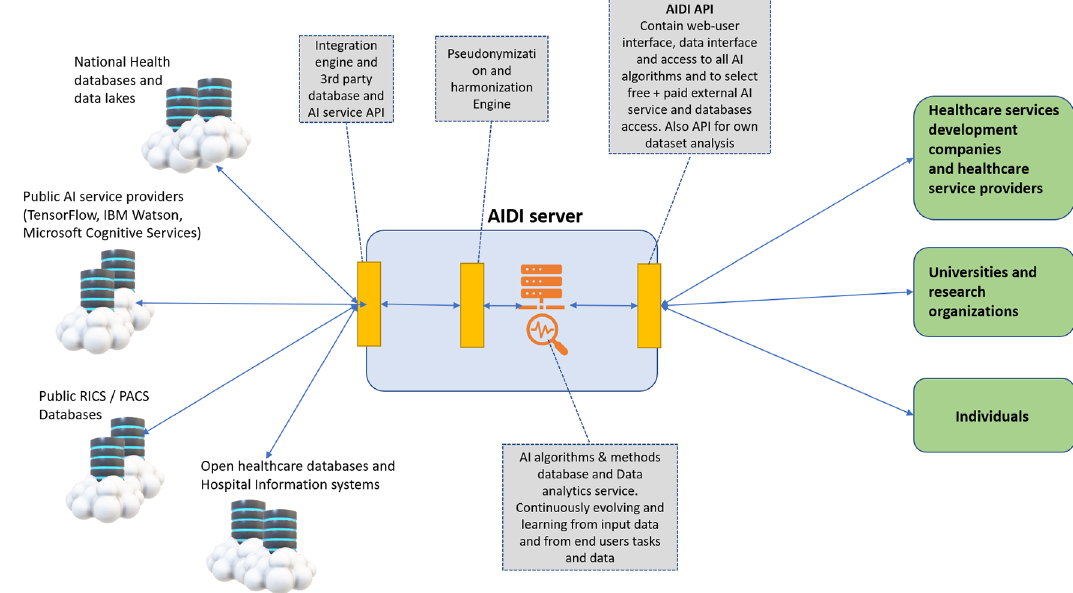
Figure 1. Basic architecture of AIDI.